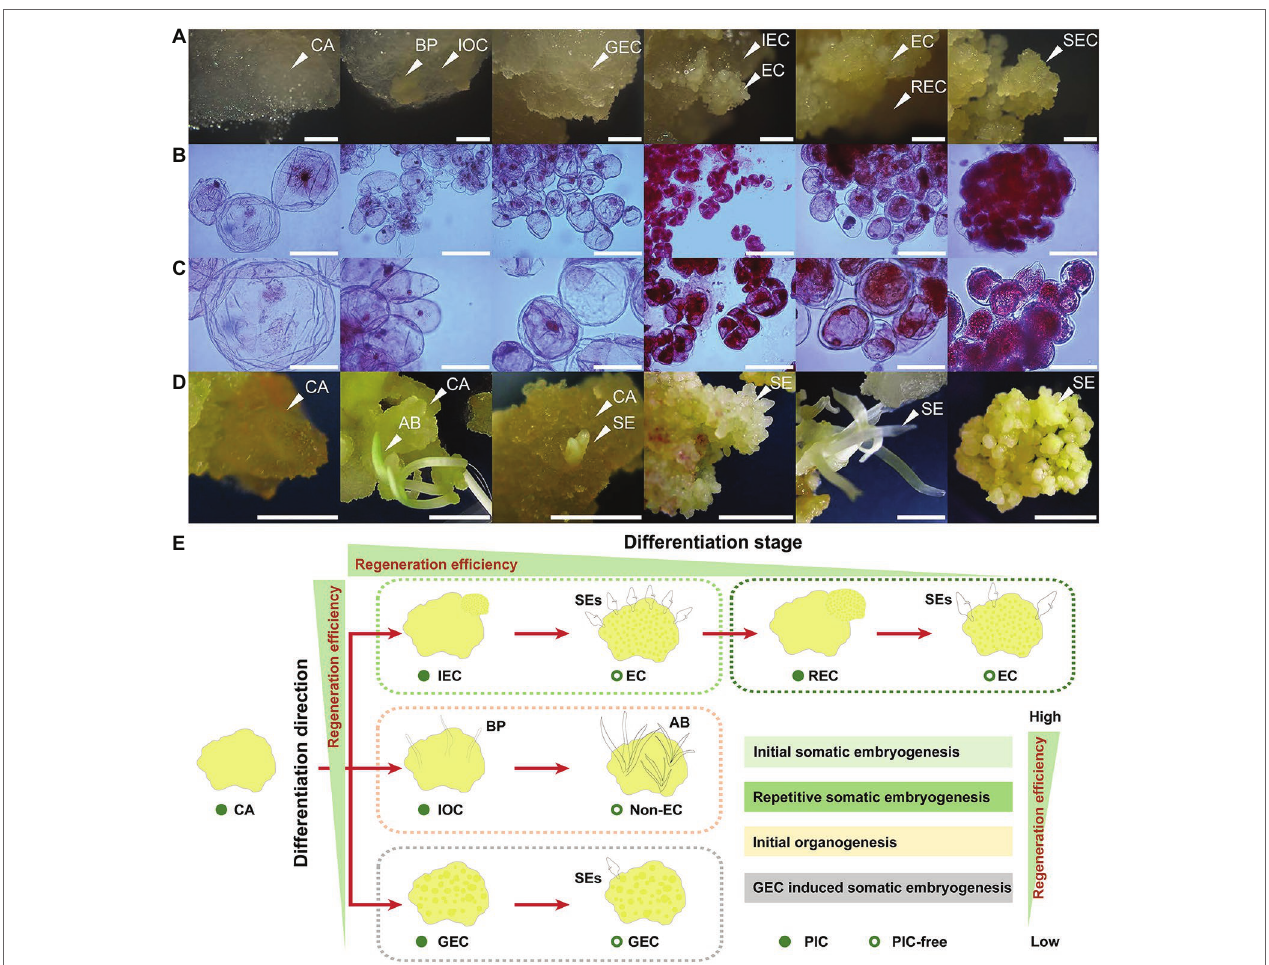
FIGURE 1 | Overview of samples employed in this study. (A) Cell morphology and structure of CA, IOC, GEC, IEC, REC, and subcultured-EC (SEC). BP indicates bud primordium; bar represents 1 mm. (B) Cell micromorphology of CA and EC; bar represents 100 μ m. (C) Cell micromorphology of CA and EC; bar represents 50 μ m. (D) Morphogenesis and regeneration efficiency of CA, IOC, GEC, IEC, REC, and SEC, induced using an auxin-free medium. AB indicates adventitious bud; bar represents 10 mm. (E) Model diagram of callus regeneration efficiency in A. praecox